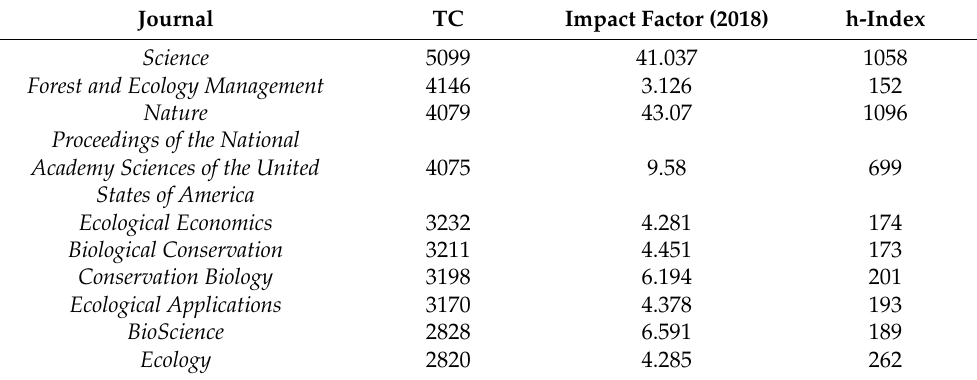
Table 2. Top 10 cited journals in terms of the number of publications on FES-related topics.